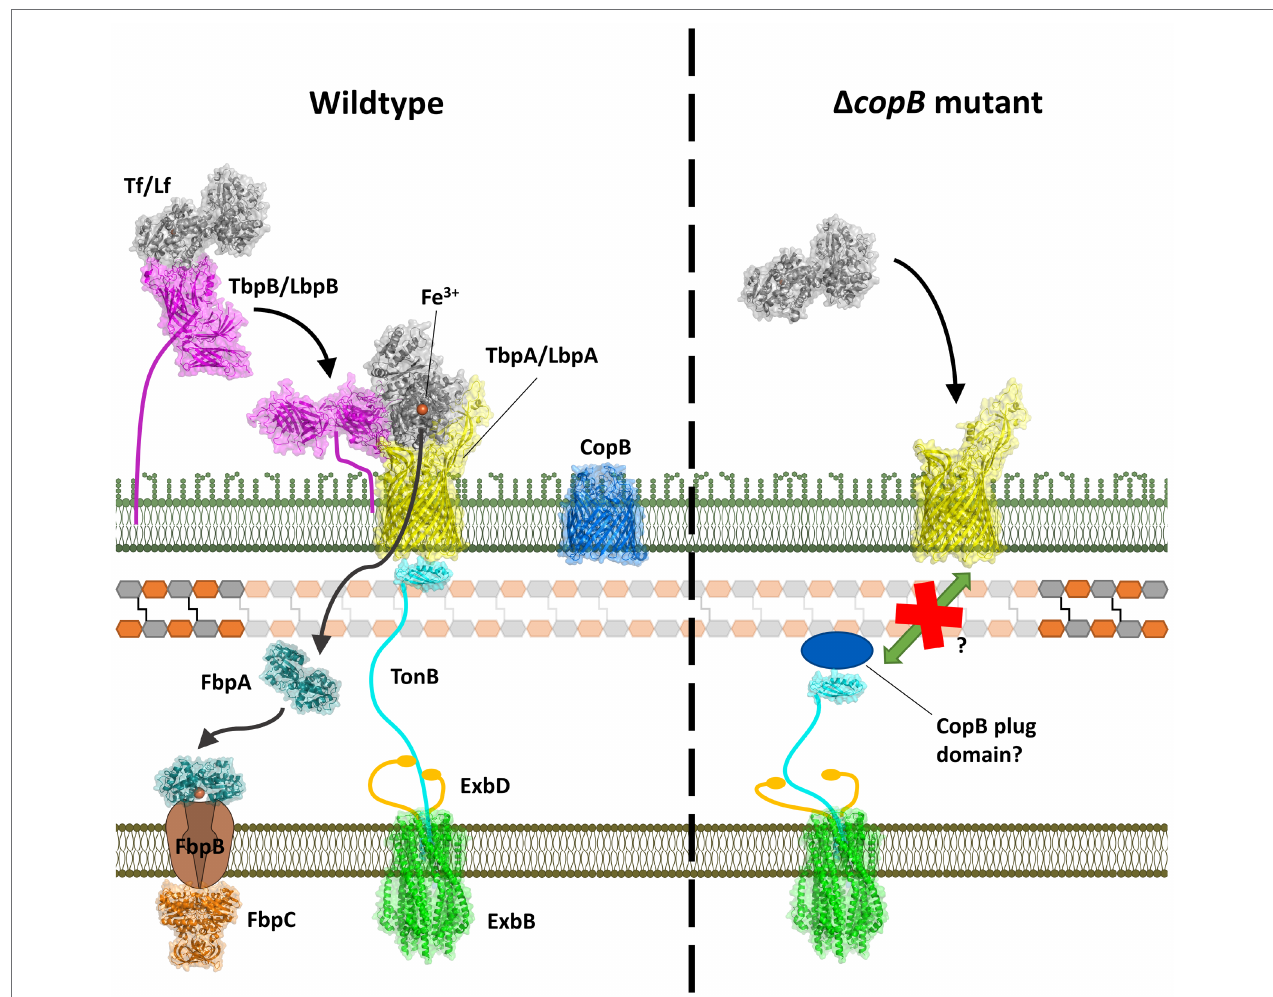
FIGURE 1 | Model for iron acquisition from Tf or Lf and its inhibition by a CopB fragment. Left panel : after capture of iron-loaded Tf/Lf by TbpB/LbpB, it is transferred to TbpA/LbpA with concomitant domain separation of the C-lobe domains. Interaction with TonB provides energy for transport of ferric ion through the TbpA/LbpA barrel which is captured by FbpA and shuttled to the inner membrane transport complex. Right panel : an N-terminal fragment generated by the insertional activation of the copB gene would be expected to produce the entire CopB plug region and interfere with TonB-mediated